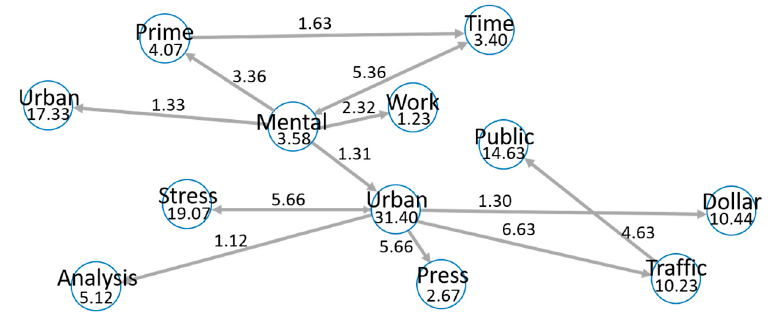
Figure 8. Rule Graph after Visualization.